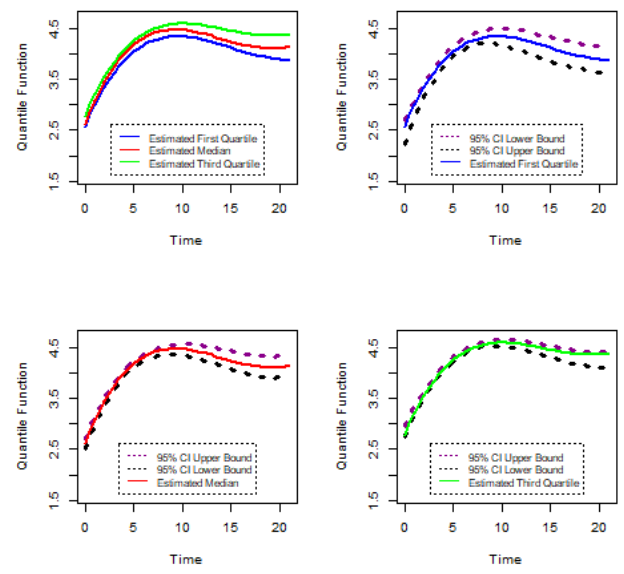
Figure 16. Confidence intervals of gene and PA0573(E6).